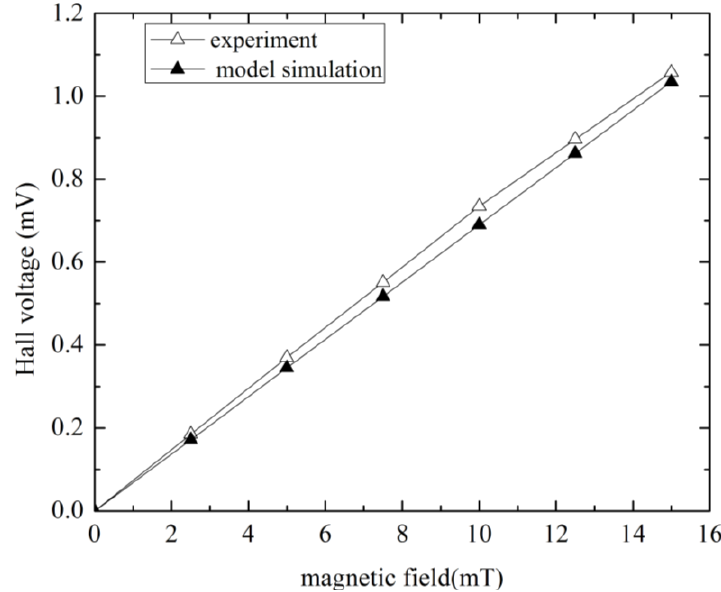
Figure 5. Comparisons between the measurements and the model simulation for the output Hall voltage with 1 mA biasing.